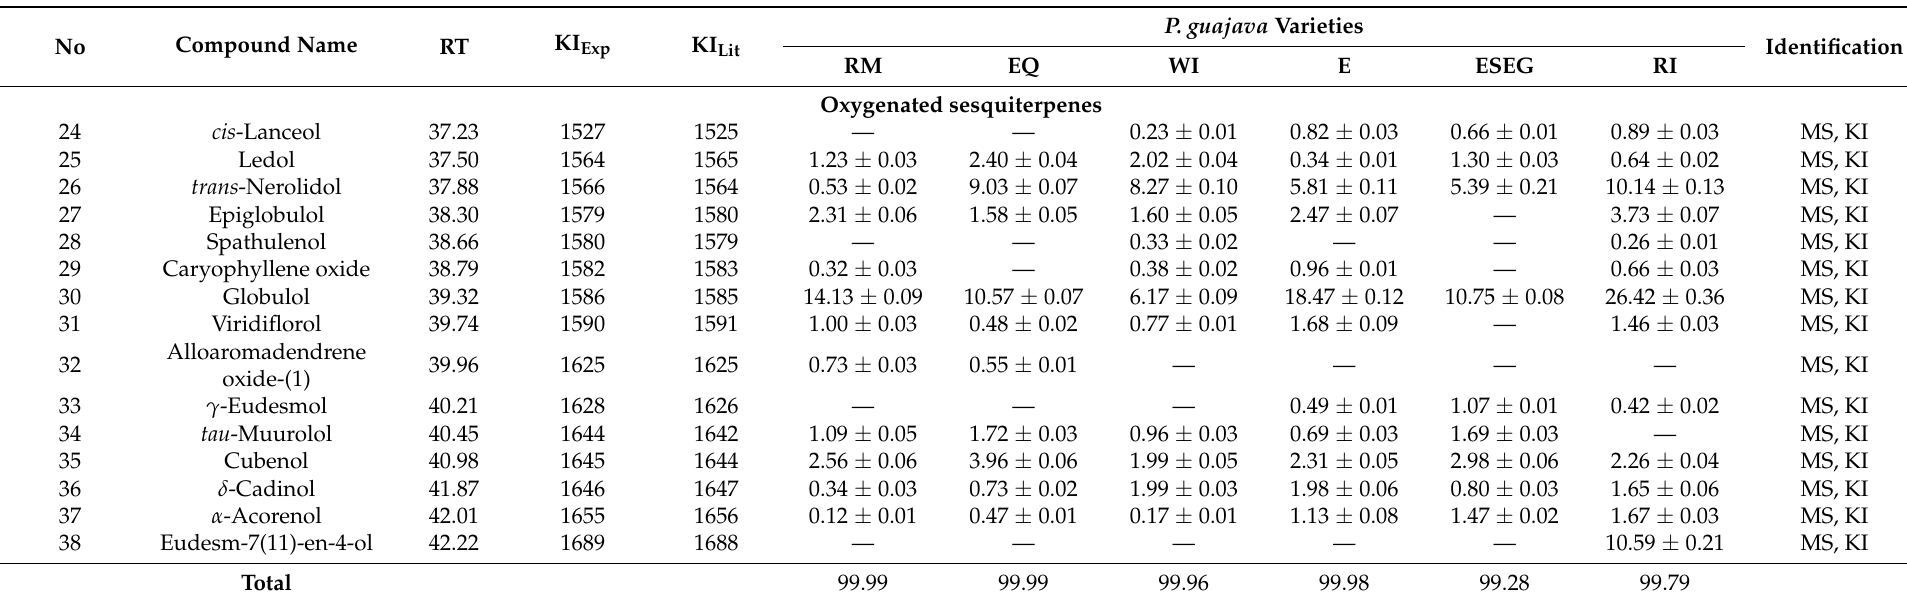
* The values represent means of the concentration (%) ± SD. RM: Red Malaysian, EQ: El-Qanater, WI: White Indian, E: Early, ESEG: El-Sabahya El-Gedida, RI: Red Indian. Rt: Retention time; KI Lit : Kovats retention index on a DB-5 column in reference to n-alkanes; KI Exp : Experimental Kovats retention index. The identification of EO components was established on the mass spectral data (MS) and Kovats indices (RI) with those of Wiley spectral library collection and NIST library